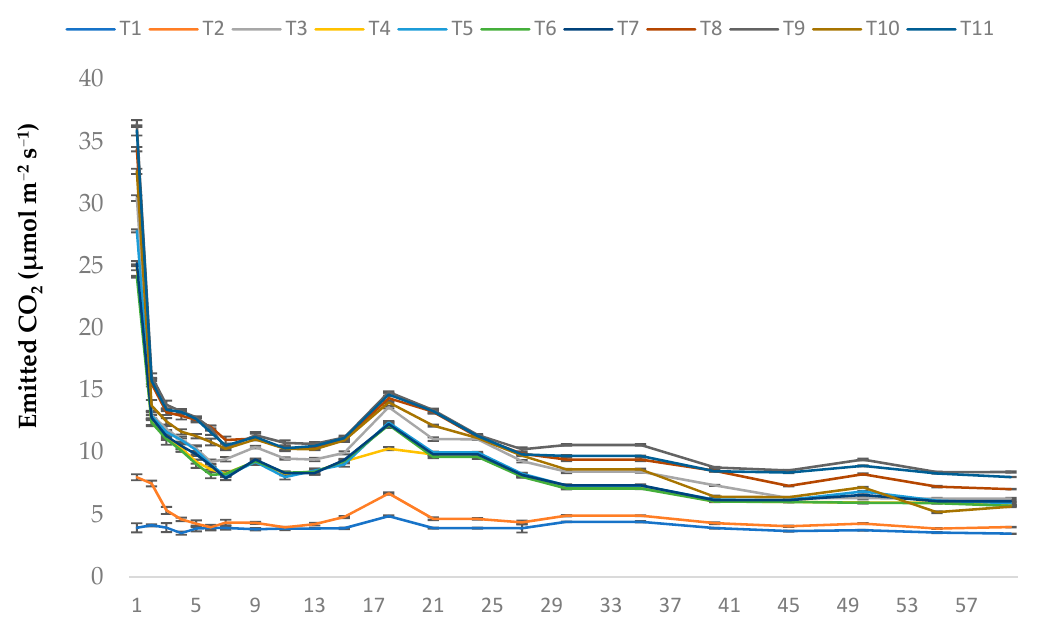
Figure 2. Effect of RHB, EFBB, and dolomitic limestone treatments on soil CO 2 emission during the 60 days of incubation. Bar errors show ± standard error of three replications.